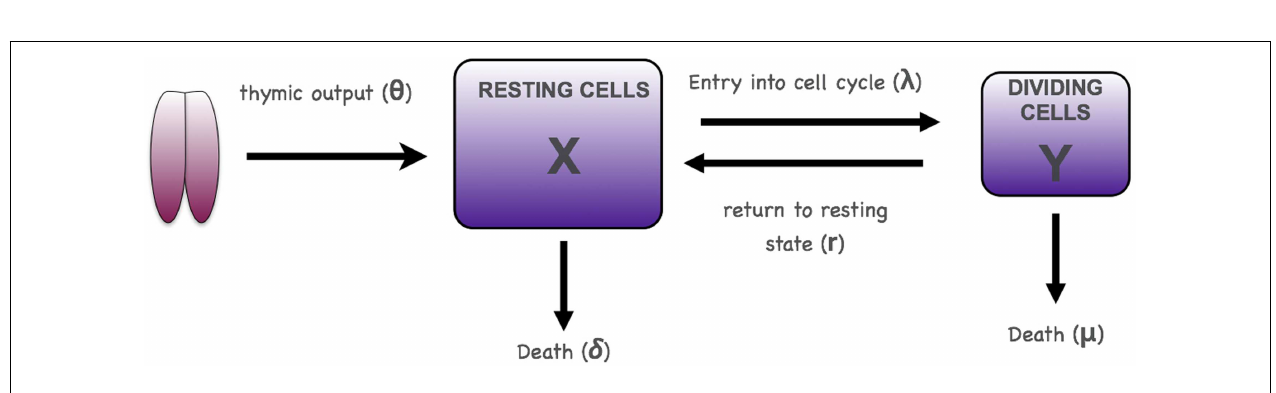
FIGURE 2 | Scheme for two-compartment model of homeostasis